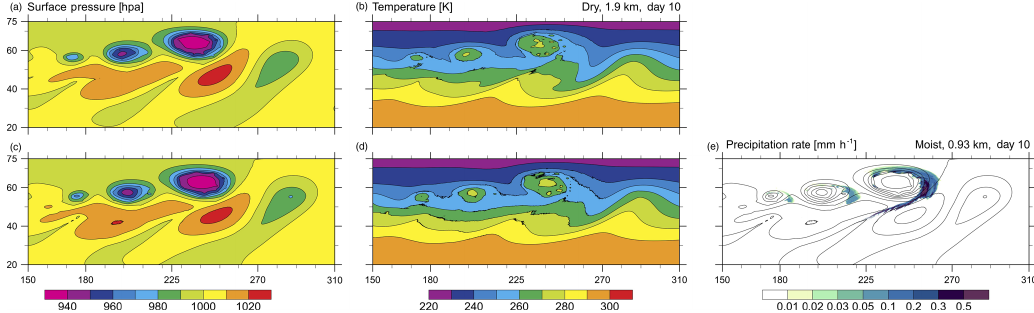
Figure 4. Output of the baroclinic wave (day 10): ( a , b ) dry simulation with 1.9km grid spacing, ( c , d , e ) moist simulation with 0.93km grid spacing, ( a , c ) surface pressure, ( b , d ) temperature on the 850hPa pressure level, and ( e )